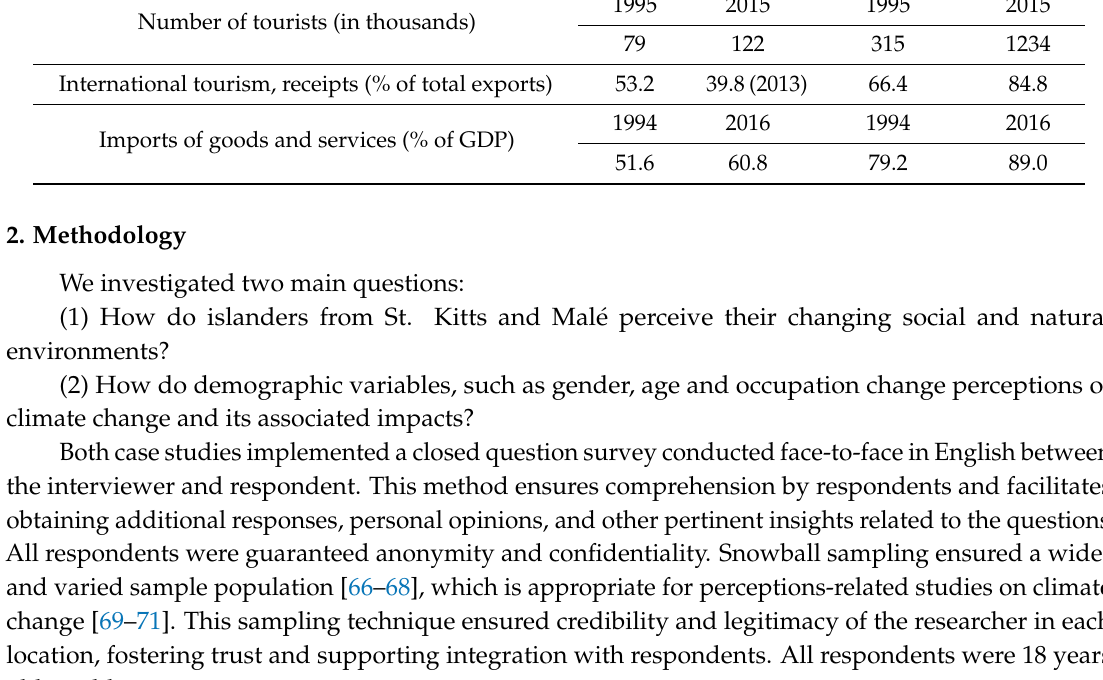
Table 1. The dependence of St. Kitts and Maldives on tourism and imported natural resources, goods and services [65]. Country St. Kitts and